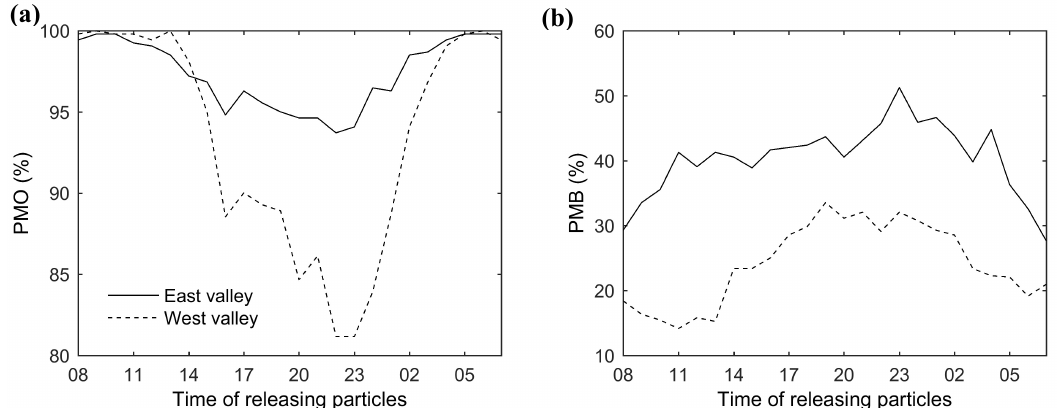
Figure 5. ( a ) Percentage of particles moving out of the urban valley after 12 h of transport (PMO) and ( b ) Ratio of particles moving back into the urban valley (PMB). The type of lines represents the location of released point.